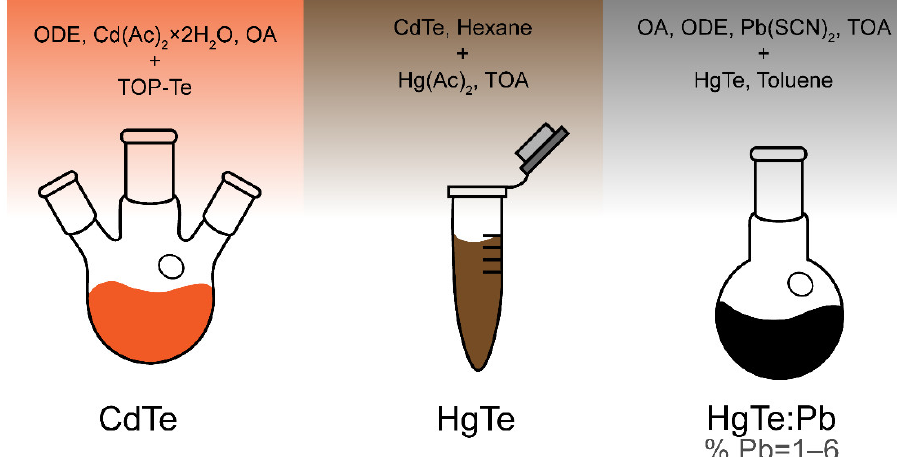
Figure 1. Step-by-step scheme of colloidal HgTe:Pb synthesis.